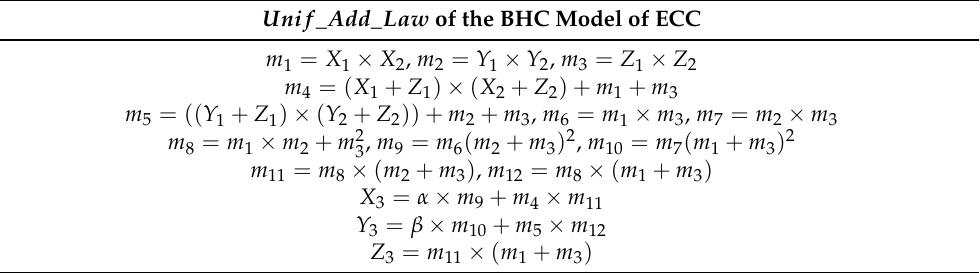
Table 1. Unif _ Add _ Law for BHC (published in [7]).